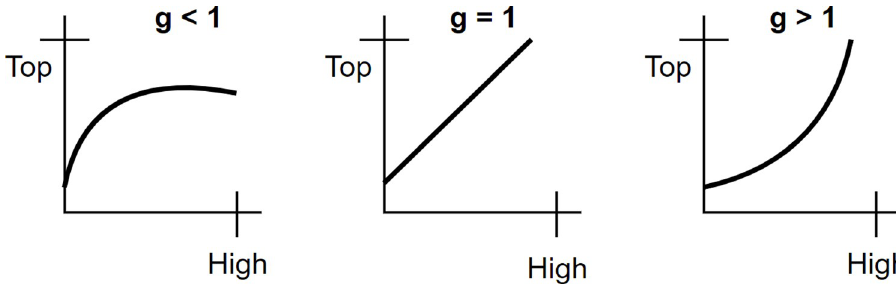
Fig 7. Plots for three gamma correction states.